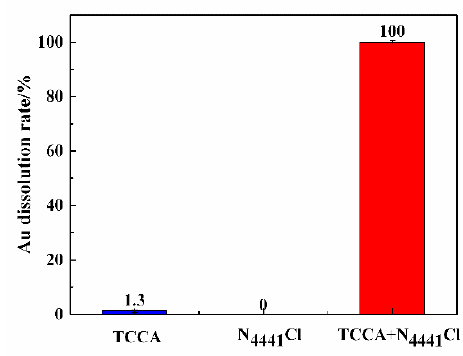
Figure 6. Difference of gold dissolving rate of single reagent and combined TCCA and N 4441 Cl.